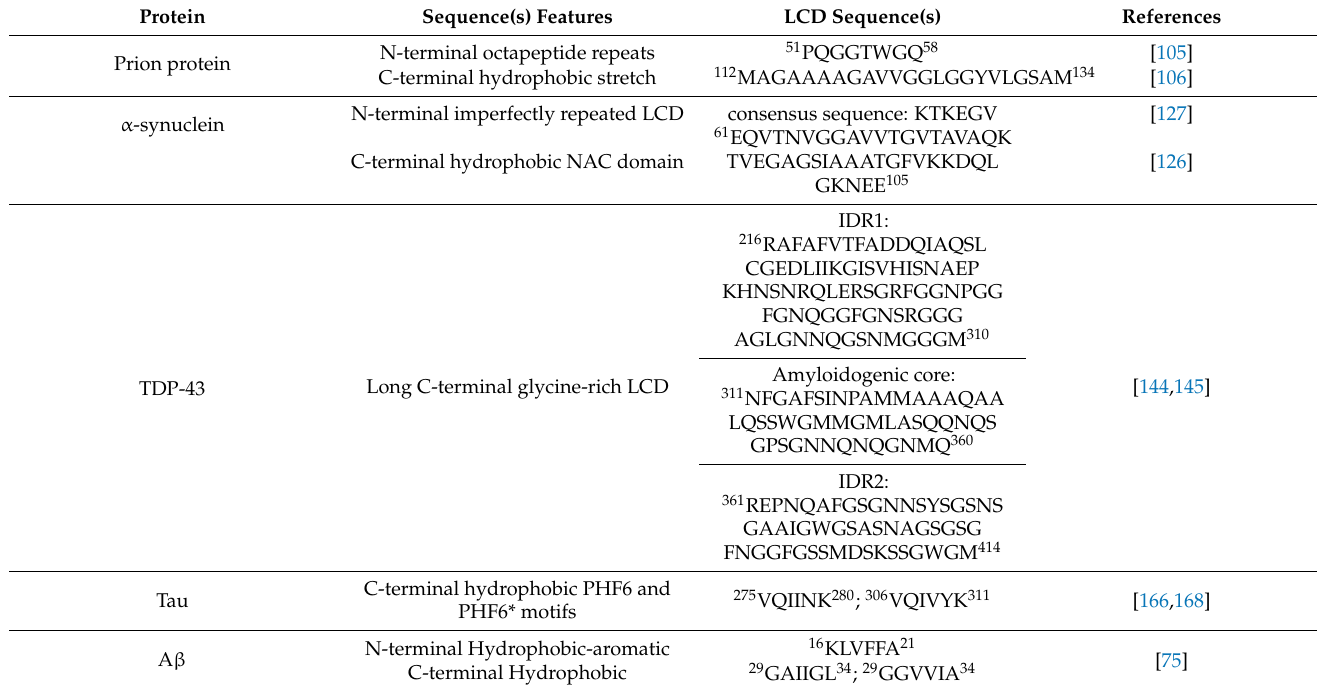
Table 3. Amyloidogenic